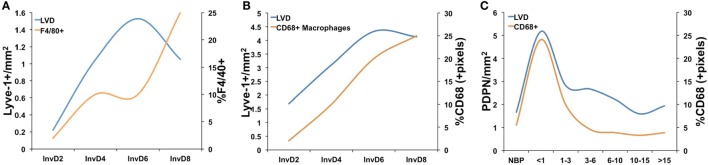
A comparison of lymphatic vessel density (LVD) and macrophage infiltration in (A) mouse mammary tissue where macrophages were measured as %F4/80+ cells from whole mammary tissue by flow cytometry [data adapted from Lyons et al. (38) and Martinson et al. (36)], (B) rat mammary tissue where macrophages were measured by quantitative IHC as %CD68+ cells/pixel [data adapted from Lyons et al. (38) and O’Brien et al. (19)], and (C) in normal human breast tissues from women who had never been pregnant (NBP), were no longer lactating, and <1, 1–3, 3–6, 6–10, 10–15, and >15 years since last childbirth where lymphatics were measured as number of podopanin+ vessels per area and CD68 by quantitative IHC [data adapted from Lyons et al. (38) and Jindal et al. (93)].